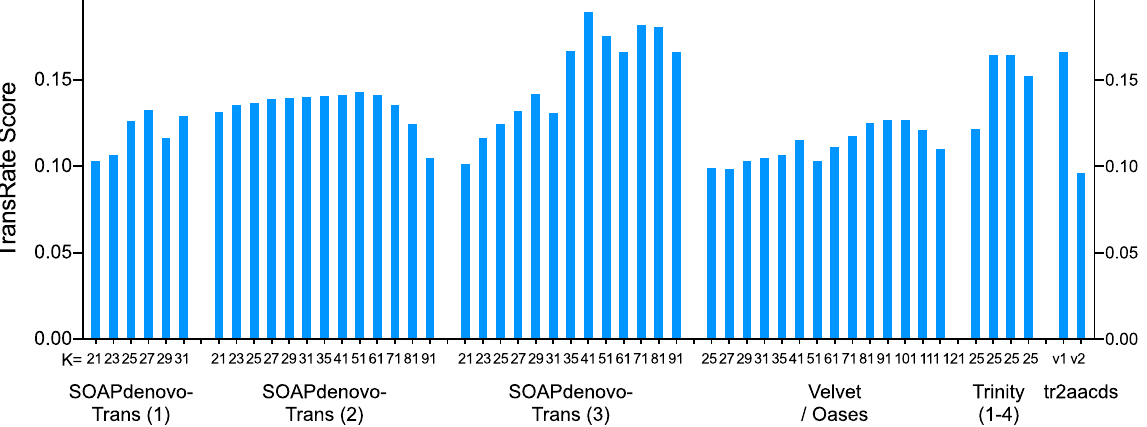
Figure 6. TransRate scores for each transcriptome assembly. SOAPdenovo-Trans (1): no filtering; (2): light filtering of poor quality read pairs, combined with in silico normalization; (3): moderate filtering of poor quality read pairs; Velvet/Oases: moderate filtering of poor quality read pairs; Trinity (1): light filtering of poor quality read pairs, combined with in silico normalization; (2): moderate filtering of poor quality read pairs; (3): light filtering of poor quality read pairs, combined with SEECER error correction; (4) Trinity v2.3.2 after moderate filtering of poor quality read pairs; (5) Gawriluk et al . transcriptome assembly; tr2aacds merged assemblies (1): pre-v2.3.2 Trinity; (2) including v2.3.2